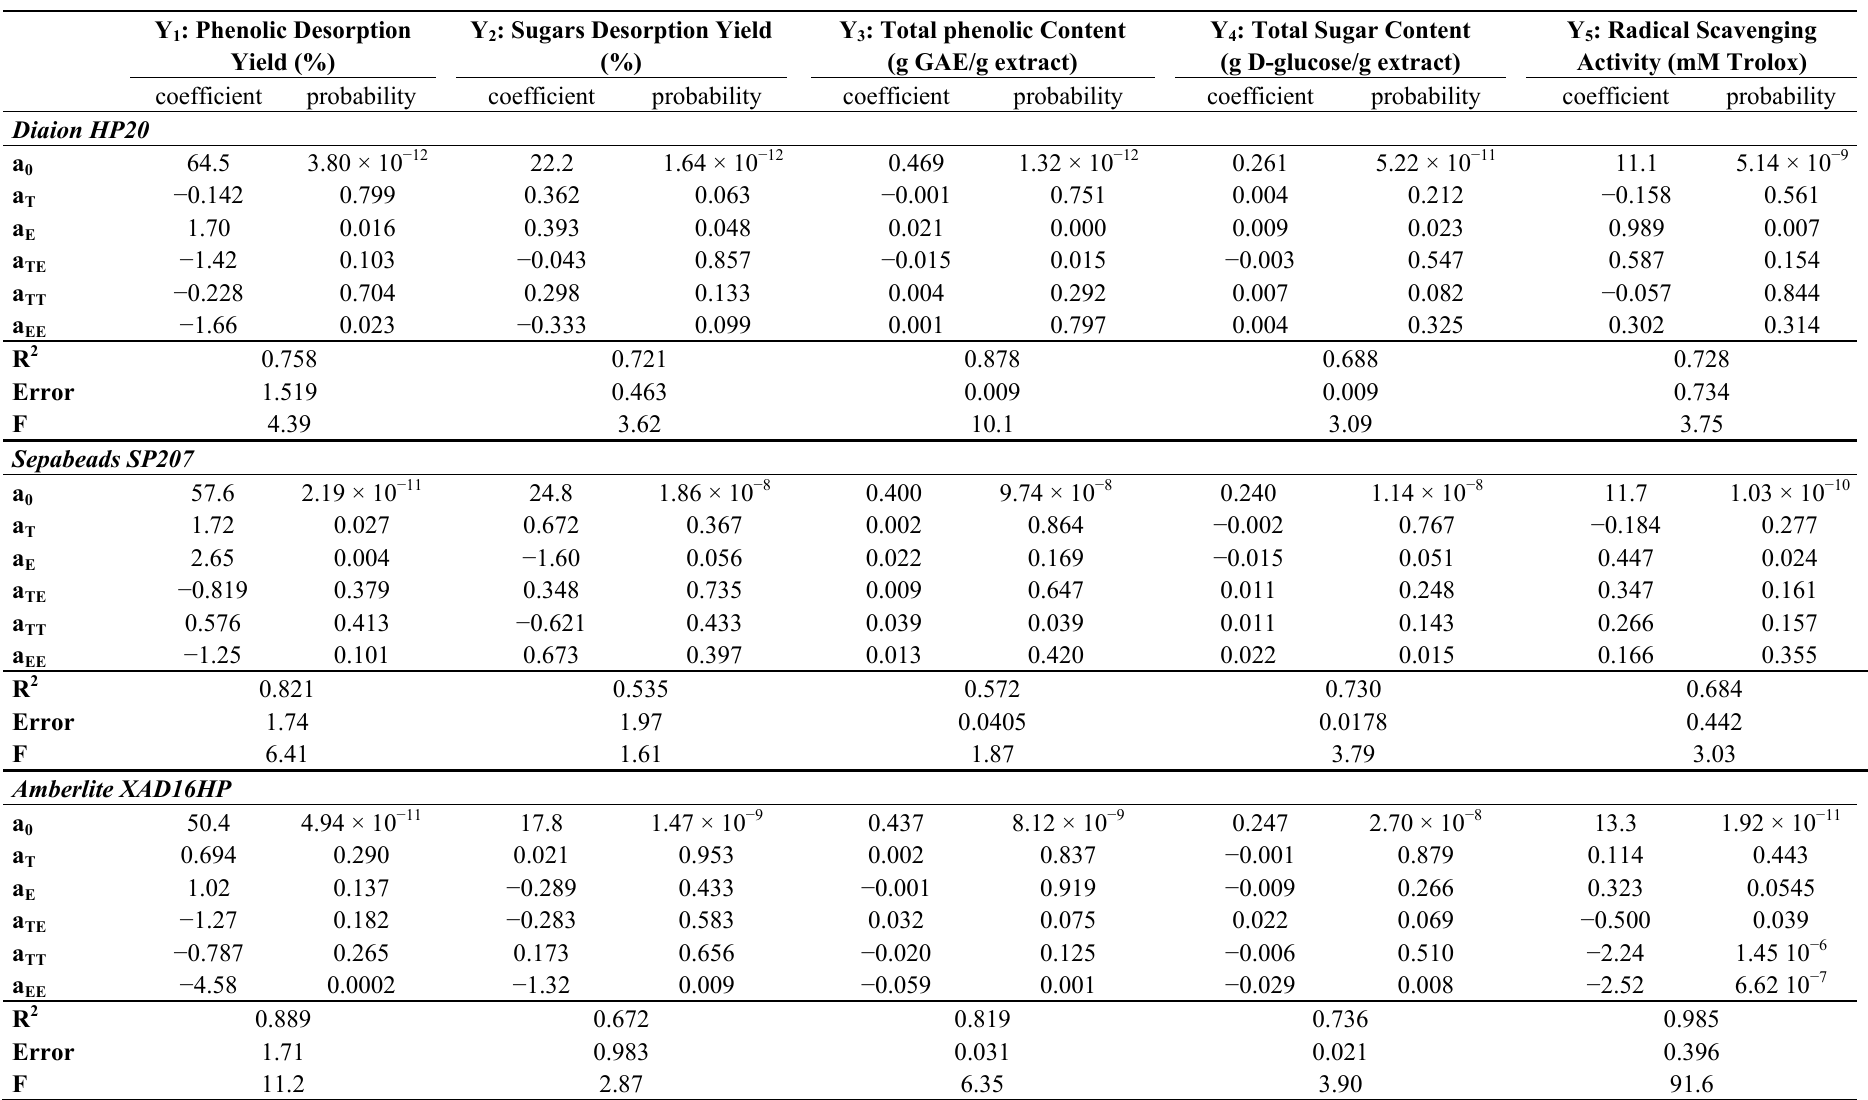
Table 5. Regression coefficients and statistical parameters for the objective functions